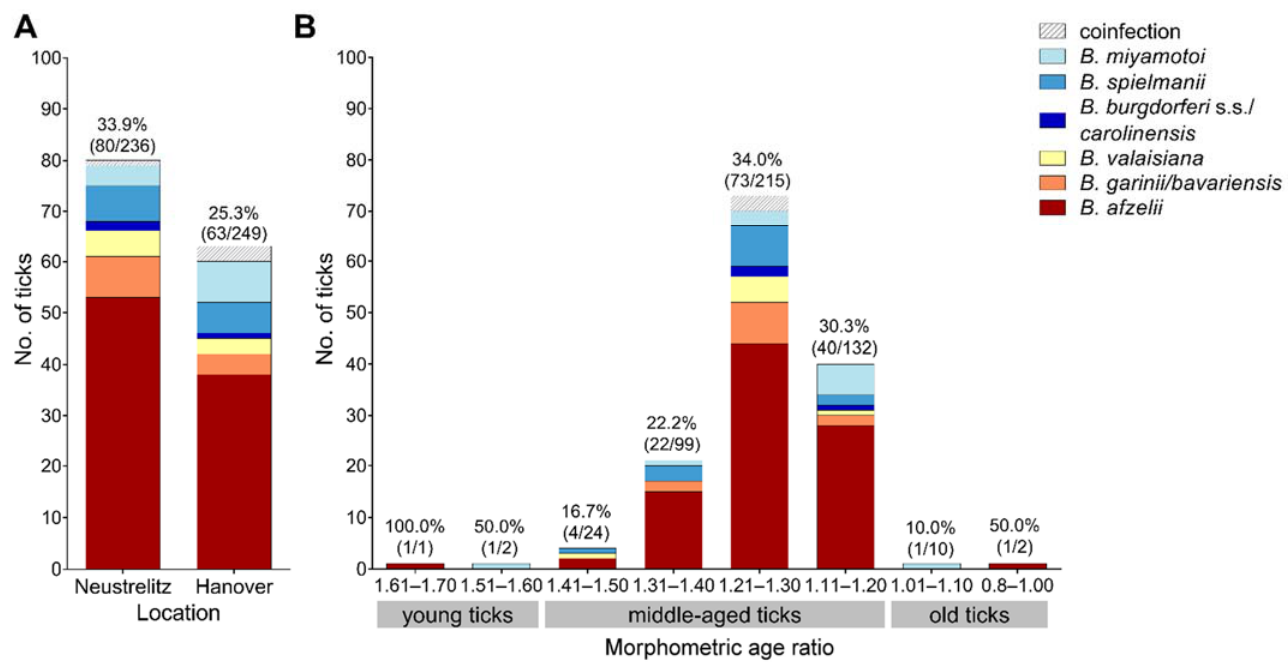
Figure 2. Borrelia spp. composition as determined by RLB among the 142 successfully differentiated samples according to ( A ) sampling location and ( B ) tick morphometric age ratio. Percentages above the bars indicate RLB differentiation success in each category. Coinfections consisted of B. garinii/bavariensis + B. valaisiana (1× in Neustrelitz, and 1× in Hanover), B. afzelii + B. valaisiana (1× in Hanover), and B. afzelii + B. miyamotoi (1× in Hanover).